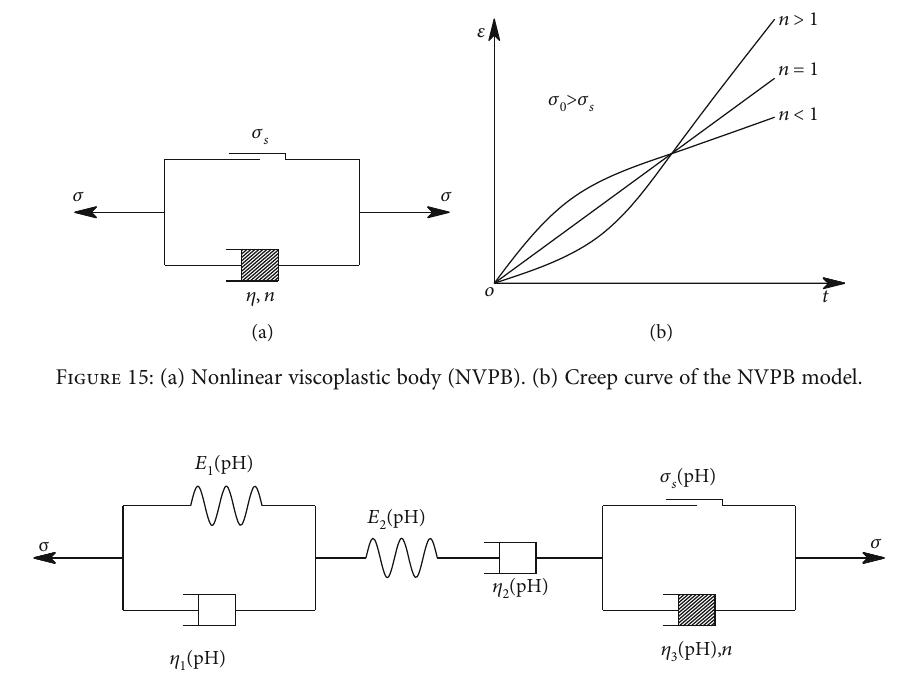
Figure 16: Nonlinear creep constitutive model of gypsum rock under acid